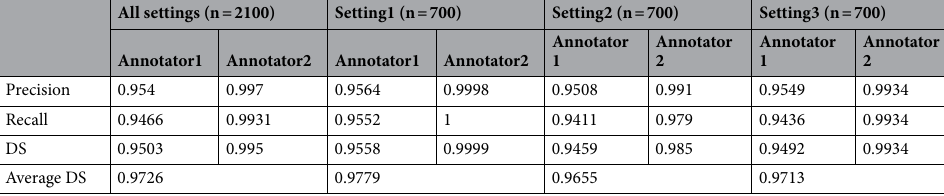
Table 4. DS across individual